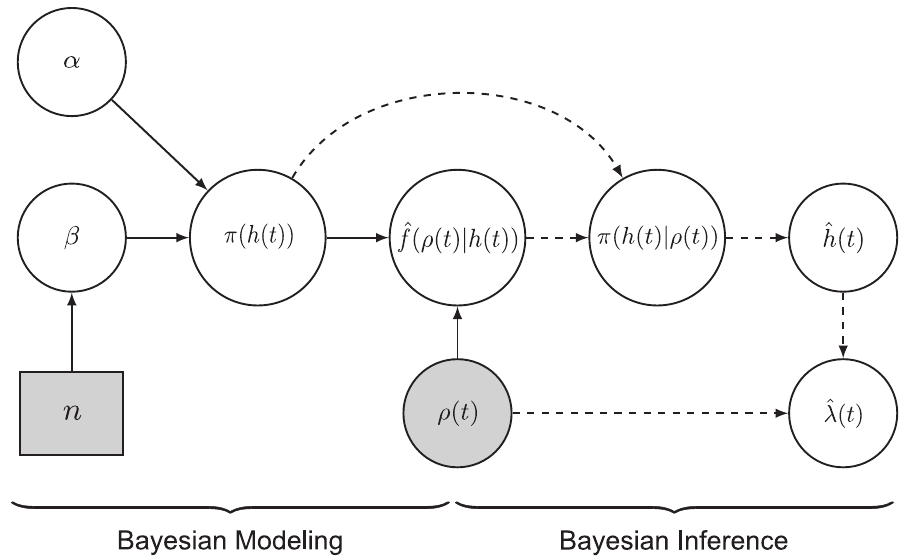
Fig 1. Graphical representation of BAKS. The various blocks describe the different components as follows: Circular blocks denote continuous variables, and rectangle blocks denote discrete variables. Shaded blocks represent observed variables, whereas white blocks represent hidden variables. Solid and dashed arrow indicate Bayesian modeling and inference phase, respectively.